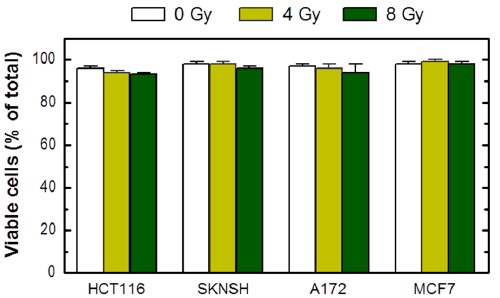
Figure 2. Viability of the indicated cell lines before (0 Gy) and 3 days after radiation exposure, evaluated by the trypan blue-exclusion assay. Bars, SE.